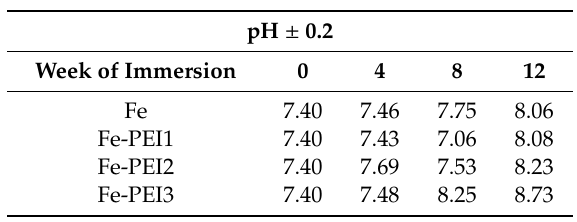
Table 5. pH of Hanks’ solution after 4 to 12 weeks long immersion of iron-based samples coated with PEI and pure iron foams.